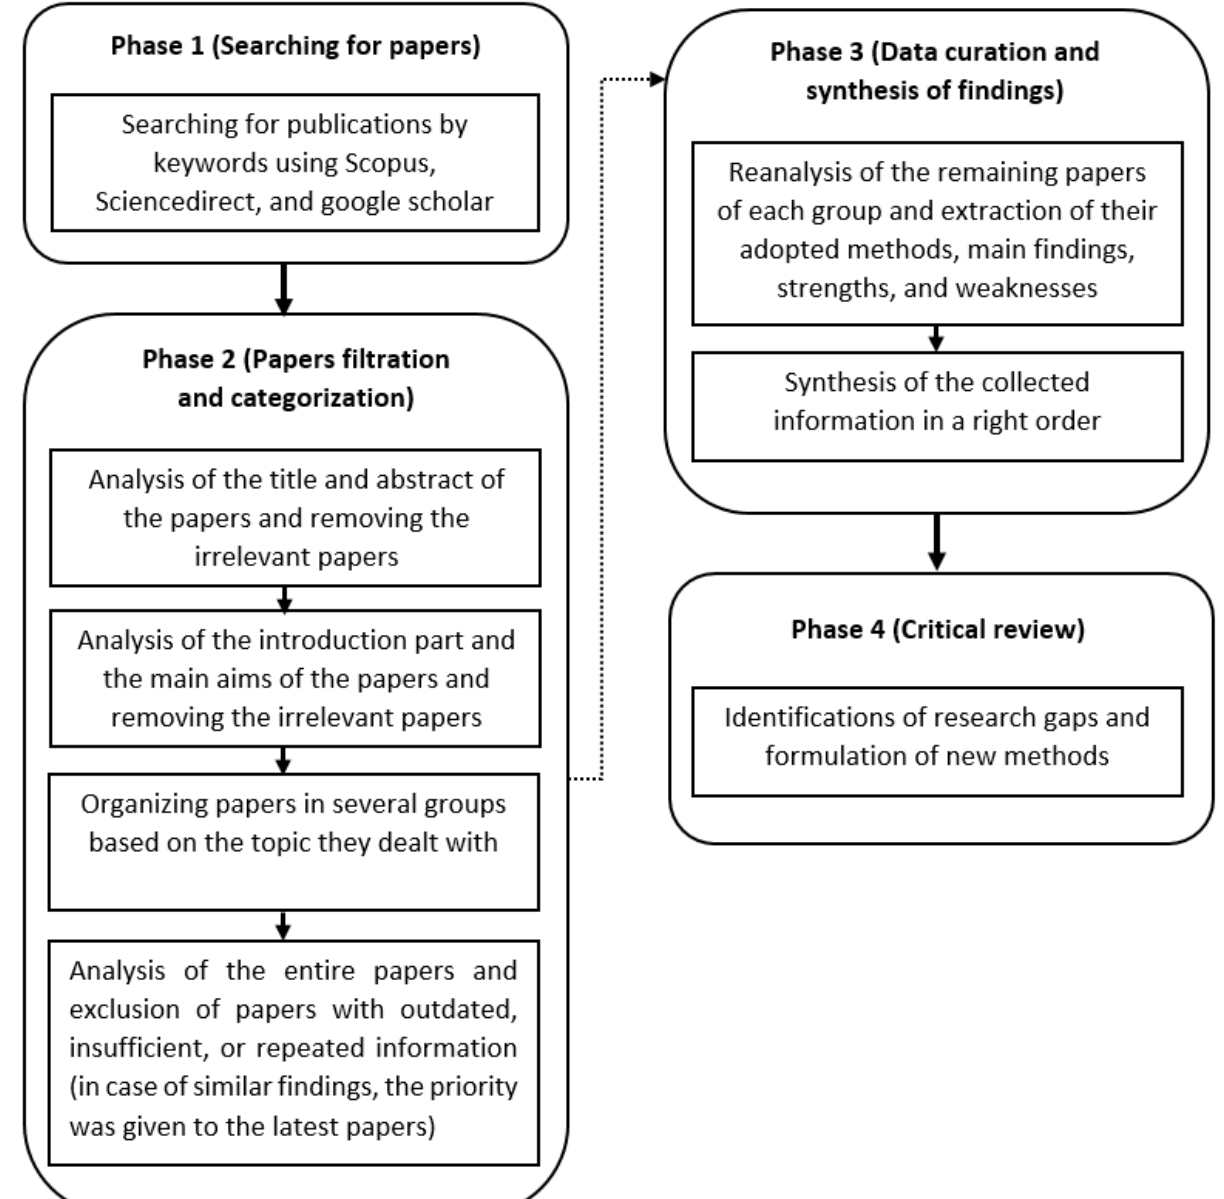
Figure 2. illustrates the study concept